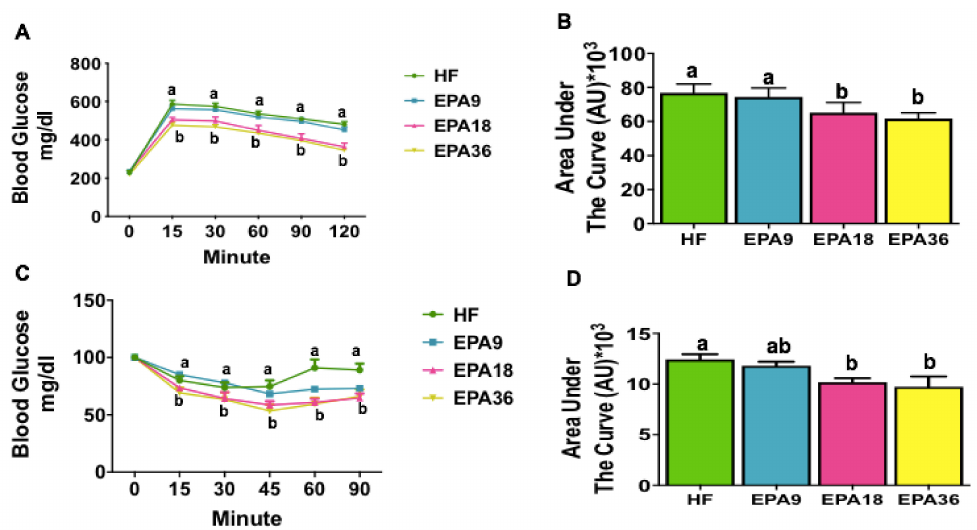
Figure 3. Dose-dependent e ff ects of EPA on glucose homeostasis in mice. ( A ) EPA18 and 36 significantly increased glucose clearance in GTT compared to HF and EPA 9, ( B ) Area under the curve of GTT. ( C ) EPA18 and 36 significantly improved insulin sensitivity in ITT compared to HF and EPA 9, ( D ) Area under the cure of ITT. Data are expressed as mean ± SEM. Groups represented with same letter indicate no di ff erence. p < 0.05; n = 15 mice per group. EPA, eicosapentaenoic acid; GTT, glucose tolerance test; HF, high fat, ITT, insulin tolerance